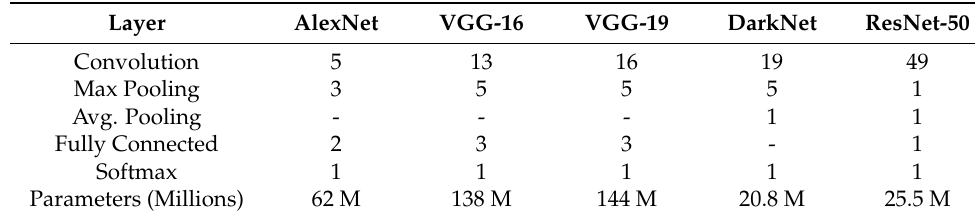
Table 2. Architectures of the state-of-the-art CNN models.